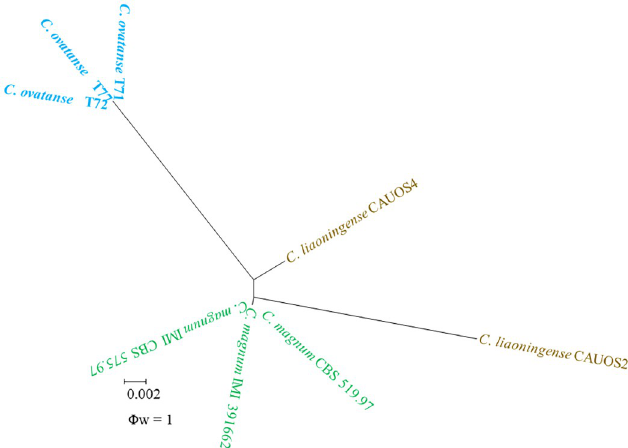
Fig 7. The result of the pairwise homoplasy index (PHI) tests of closely related species using both LogDet transformation and splits decomposition. Resulting PHI test value ( F w) < 0.05 indicate significant recombination within the